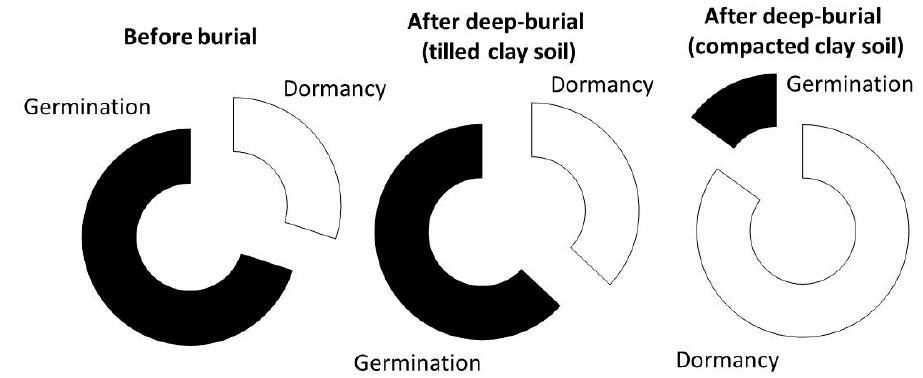
Figure 4. Germination and dormancy percentage of Portulaca oleracea seeds before and after deep-burial in tilled and compacted clay soil.